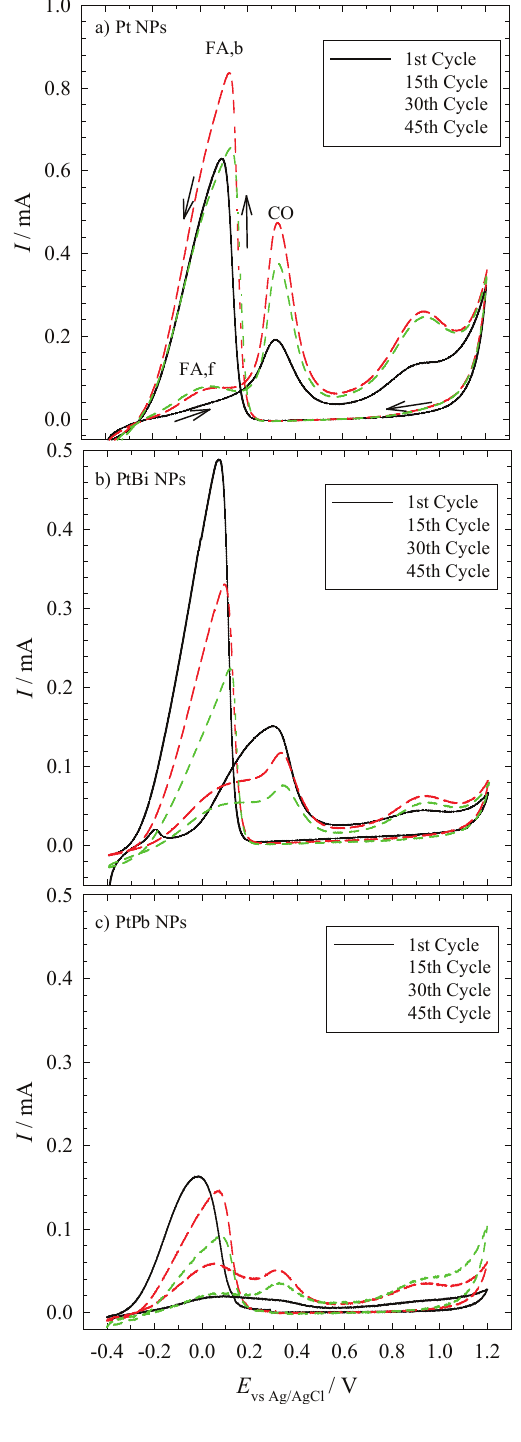
Figure 1. Cyclic voltammograms of a glassy carbon (GC) electrode coated with mono- and bi-metallic NPs. The electrolyte contained 0.5 M formic acid/0.1 M sulfuric acid. The sweep rate is 10 mV ∙ s − 1 . The GC electrode was coated with ( a ) Pt NP, ( b ) PtBi NP and ( c ) PtPb NP, and the potentials are measured against an Ag/AgCl electrode. Please note that the y-scale of the upper figure is different from the two lower